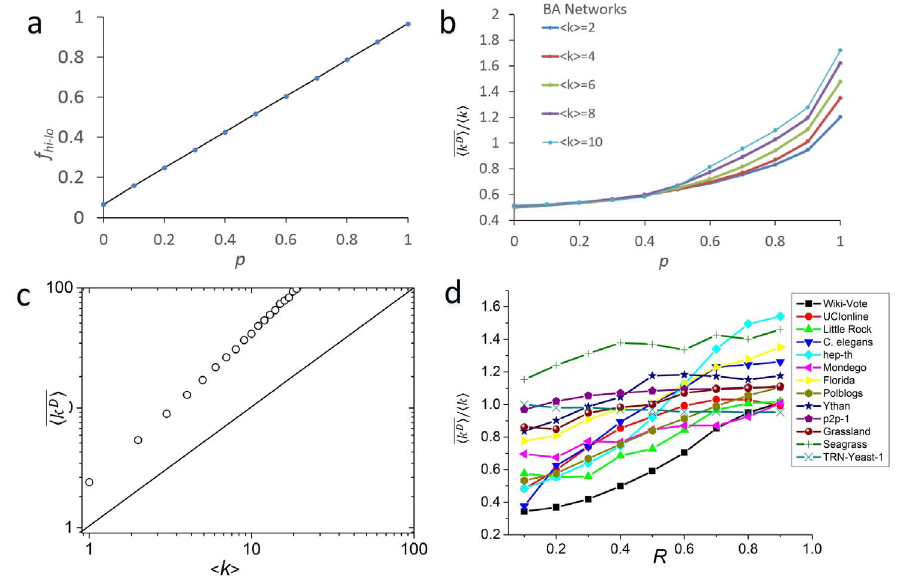
Figure 5. Edge direction strongly influences the average degree of MDSs. (a) The fraction f hi-lo and the probability p have a clear linear relation in directed BA networks; (b) the ratio of v k D w and , k . increase with p in directed BA networks; (c) the v k D w of all directed BA networks is always greater than , k . when p =1; (d) the ratio of v k D w to , k . increases with the reversal probability R in real networks.